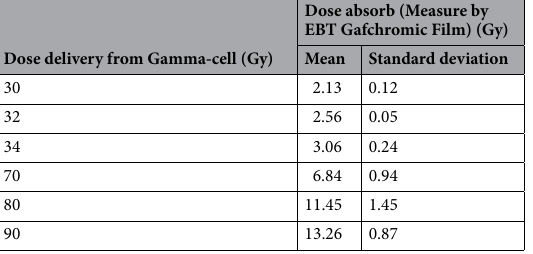
Table 1. The absorbed dose in the beam path from different delivery dose. n = 2.